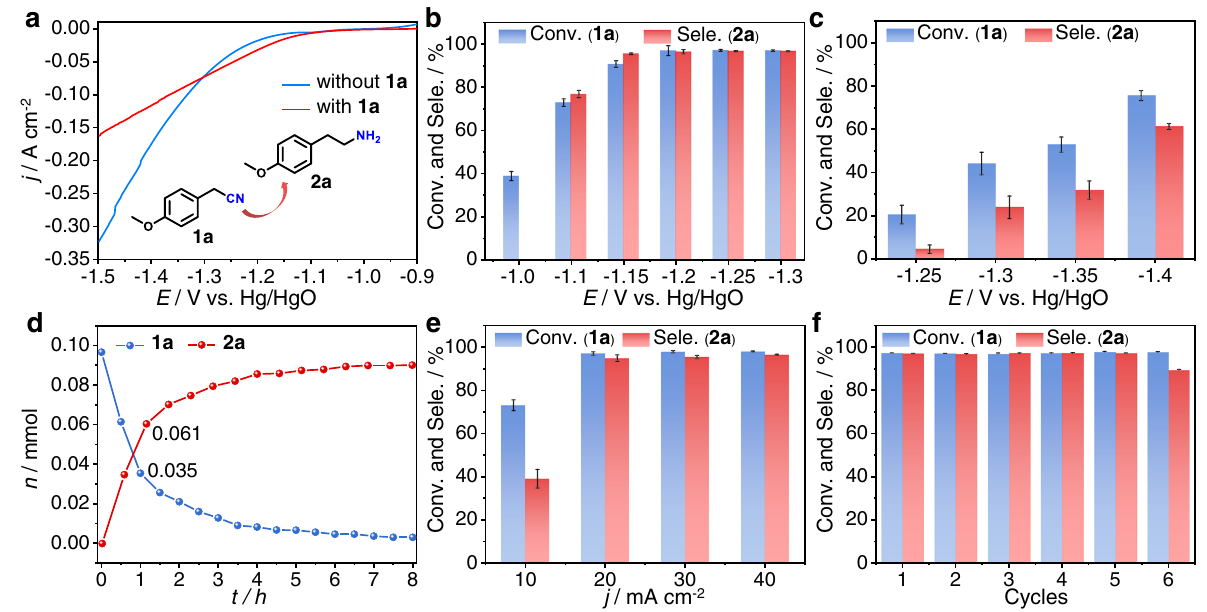
Fig.3|Performancesoftheelectrocatalytichydrogenationof1aovertheLC-Fe cathode. a LSV curves of LC-Fe at a scan rate of 10mVs -1 in 1.0M KOH/dioxane (3:1v/v,8mL)mixedsolutionwithandwithout 1a .Potential-dependentconversion (Conv.) of 1a and selectivity (Sele.) of 2a over b LC-Fe and c Fe Foil, respectively. d Time-dependent 1a Conv. and 2a Sele. over LC-Fe. e Galvanostaticelectrolysis of